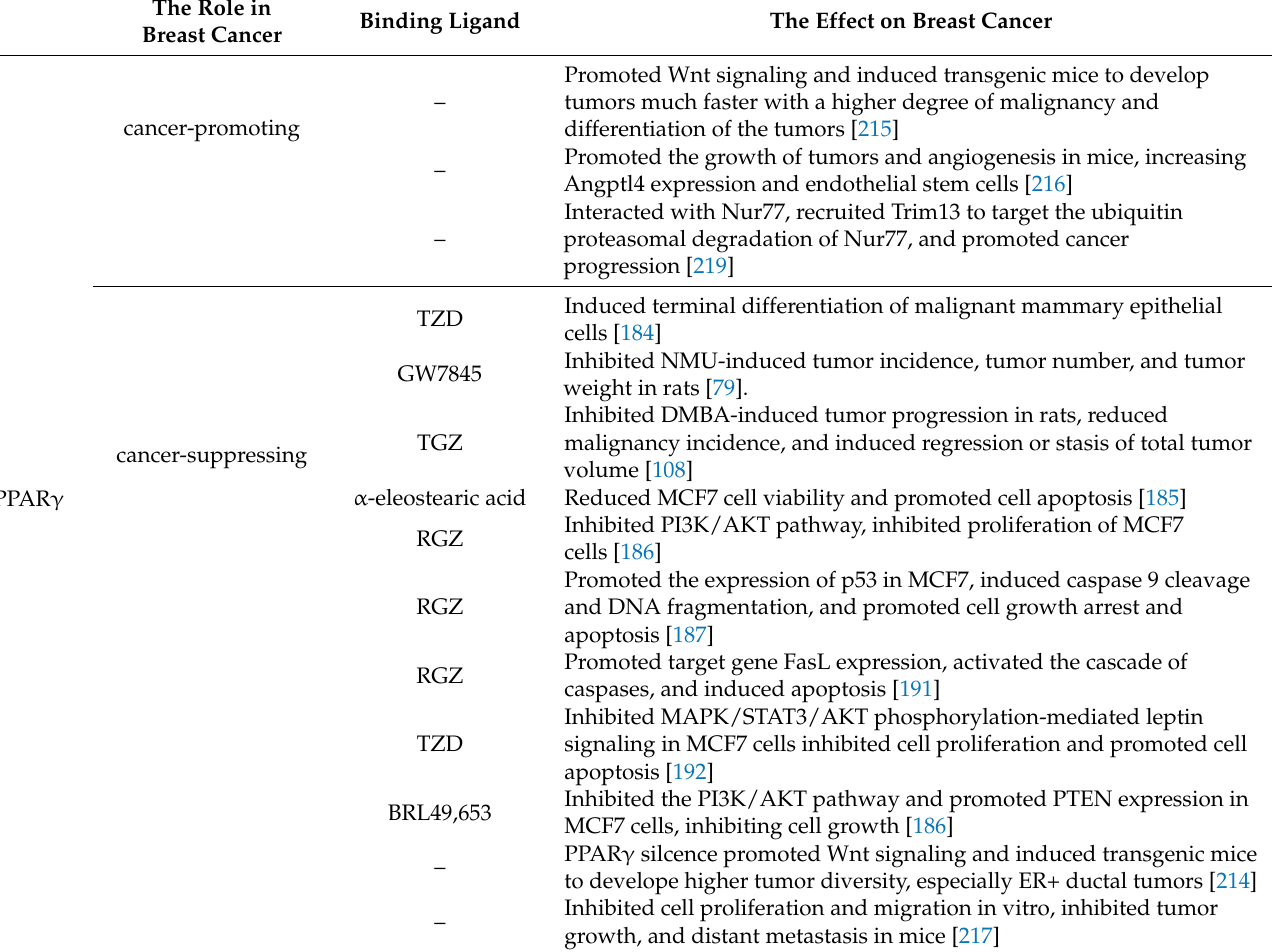
Table 4. The effects of PPAR γ on breast